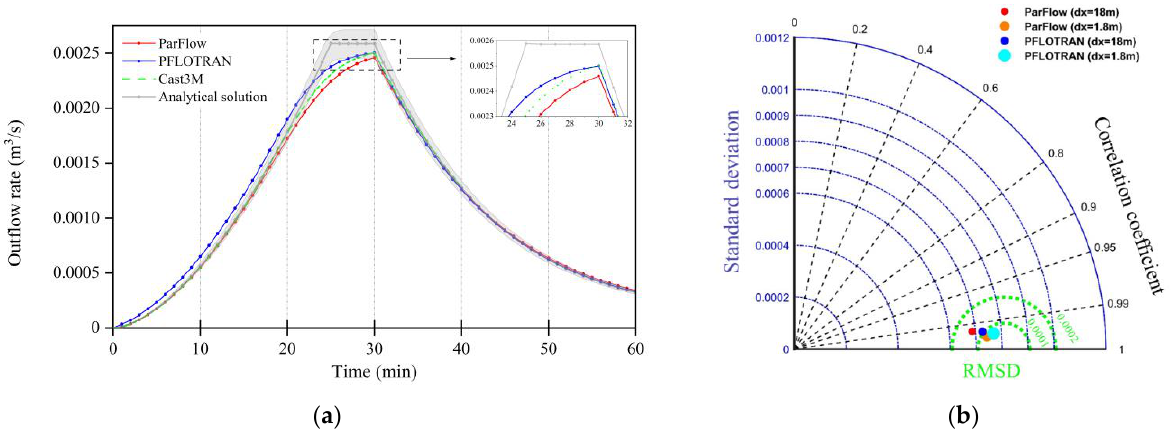
Figure 10. Outflow response comparison among ParFlow, PFLOTRAN, Cast3M and analytical solution for 1D parking lot case: ( a ) Time-series comparison plots. 5% error of analytical solution is drawn in gray as well; ( b ) Taylor diagram for ParFlow and PFLOTRAN, including SD, R, RMSD and normalized computational efficiency (the smaller size, the higher efficiency).